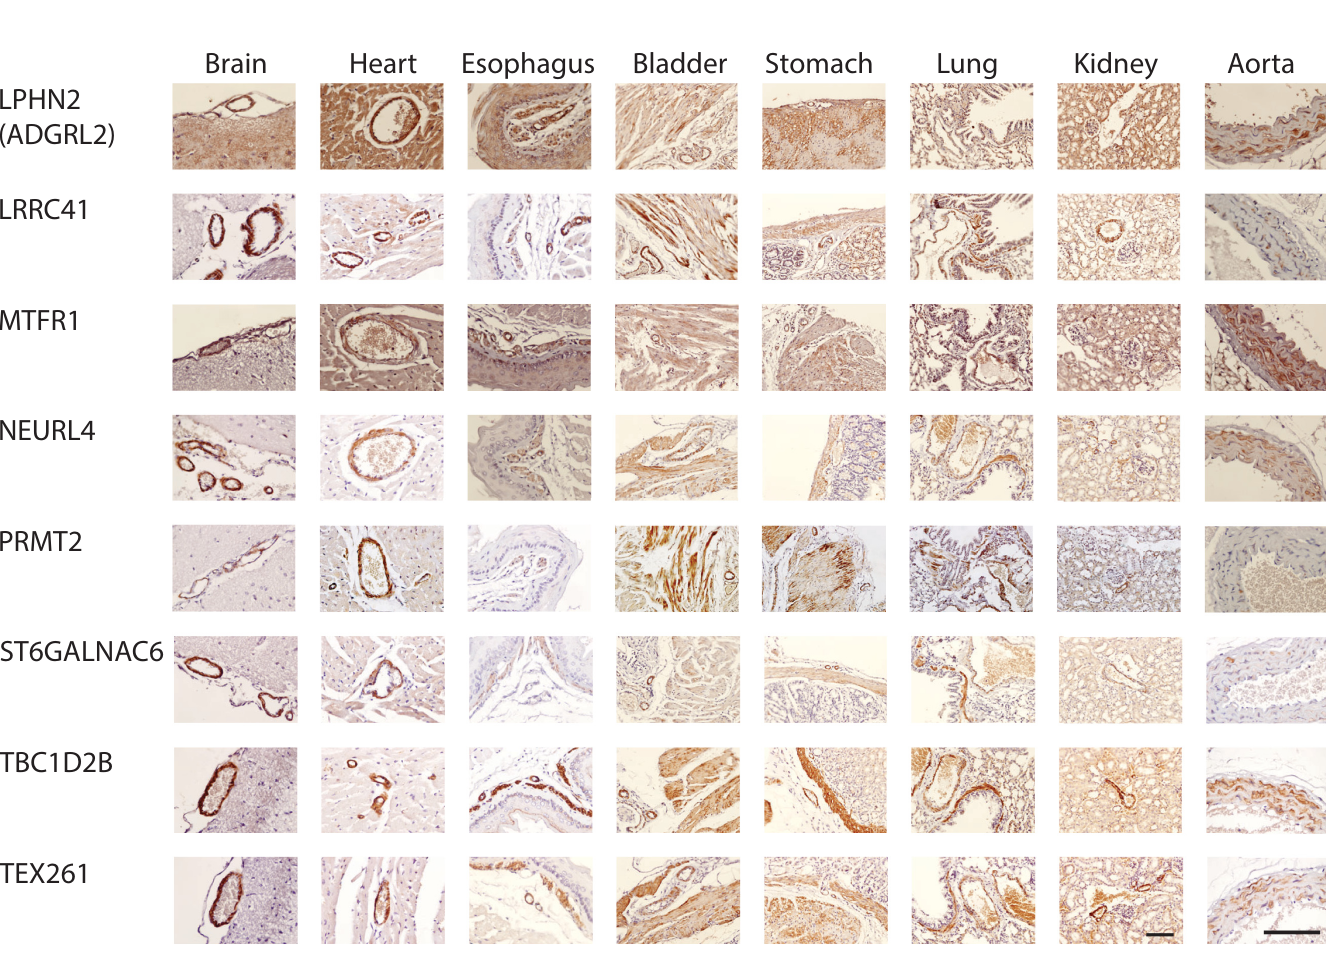
PLOS ONE | https://doi.org/10.1371/journal.pone.0227672 January 16,